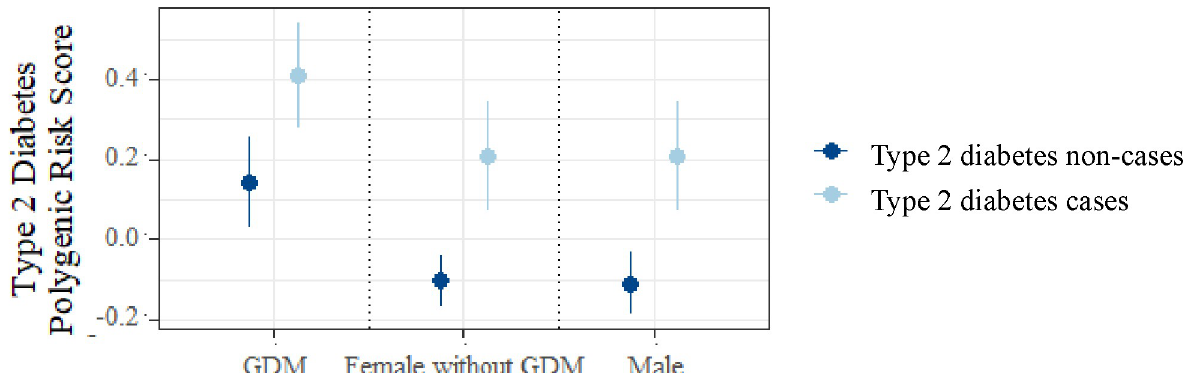
Fig 4. Mean T2D PRS in women with GDM. Mean T2D PRS in women with GDM who subsequently did and did not develop T2D, compared to age- and BMI-matched control groups of females without GDM, and males. Data are presented as group mean with 95% CIs according to sex-by- GDM subgroup, stratified by subsequent T2D status. BMI, body mass index; CI, confidence interval; GDM, gestational diabetes mellitus; PRS, polygenic risk score; T2D, type 2 diabetes.